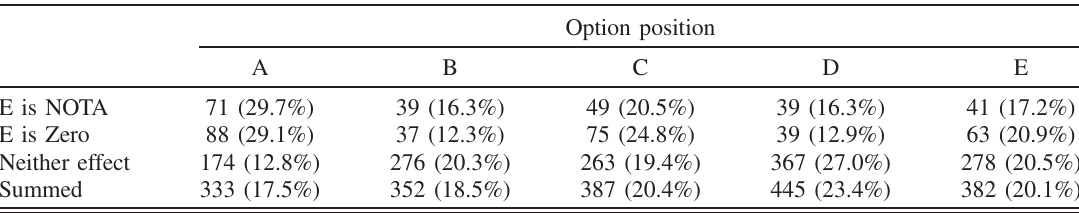
TABLE VI. Distribution of correct answers for 5 option multiple-choice questions from data set